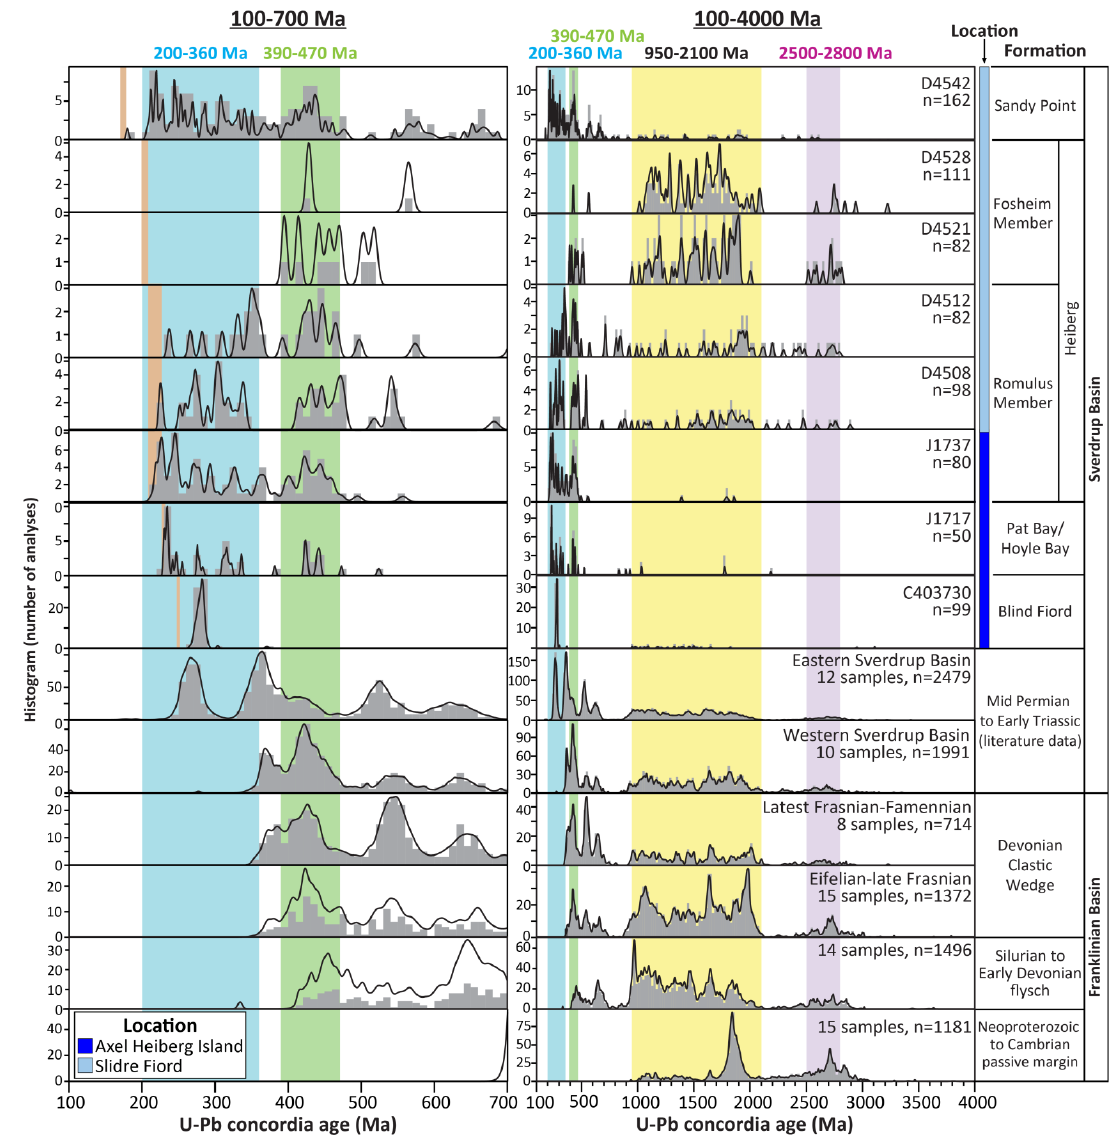
Figure 10. Combined probability density plots and histograms showing the detrital zircon U–Pb age data obtained from Triassic to Middle Jurassic samples analysed from the northern margin and axial areas of the Sverdrup Basin. Approximate depositional ages shown in the left-hand panel (brown bars) are from Figure 2 with stratigraphic ranges referenced to Cohen et al. [70]. The histogram bin width is 10 and 20 Ma in the left- and right-hand columns, respectively. The spectrum from sample C403730 includes reprocessed data from Omma et al. [34]. Published data from Middle Permian to Early Triassic strata are from Alonso-Torres et al. [15], Anfinson et al. [32], Galloway et al. [31] and Hadlari et al. [30]. Data from the Franklinian Basin succession are the same as those drawn in Figure 9.